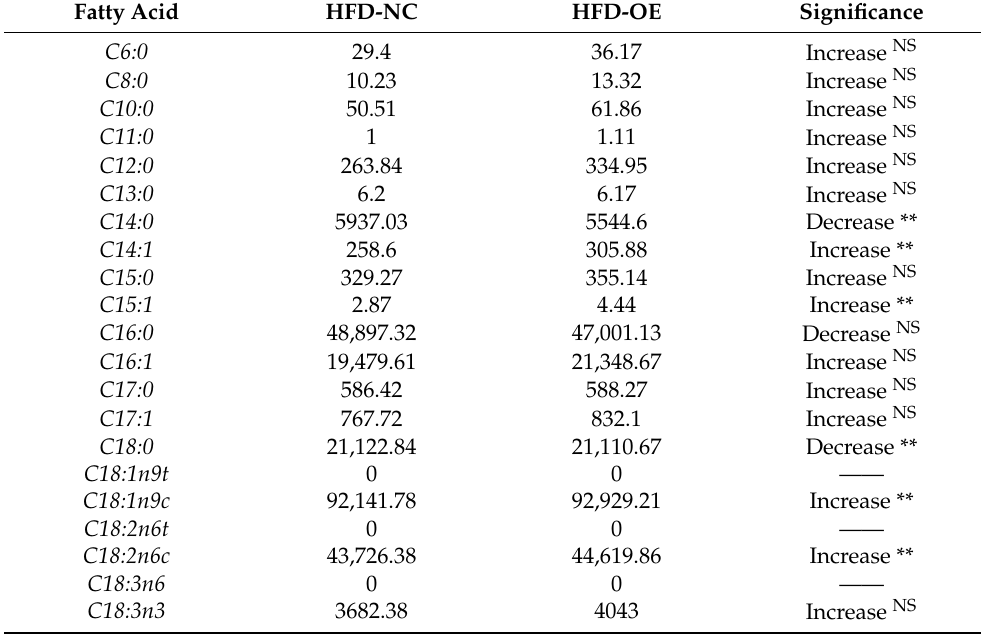
Table 2. miR-370-3p regulates fatty acid composition in vitro.